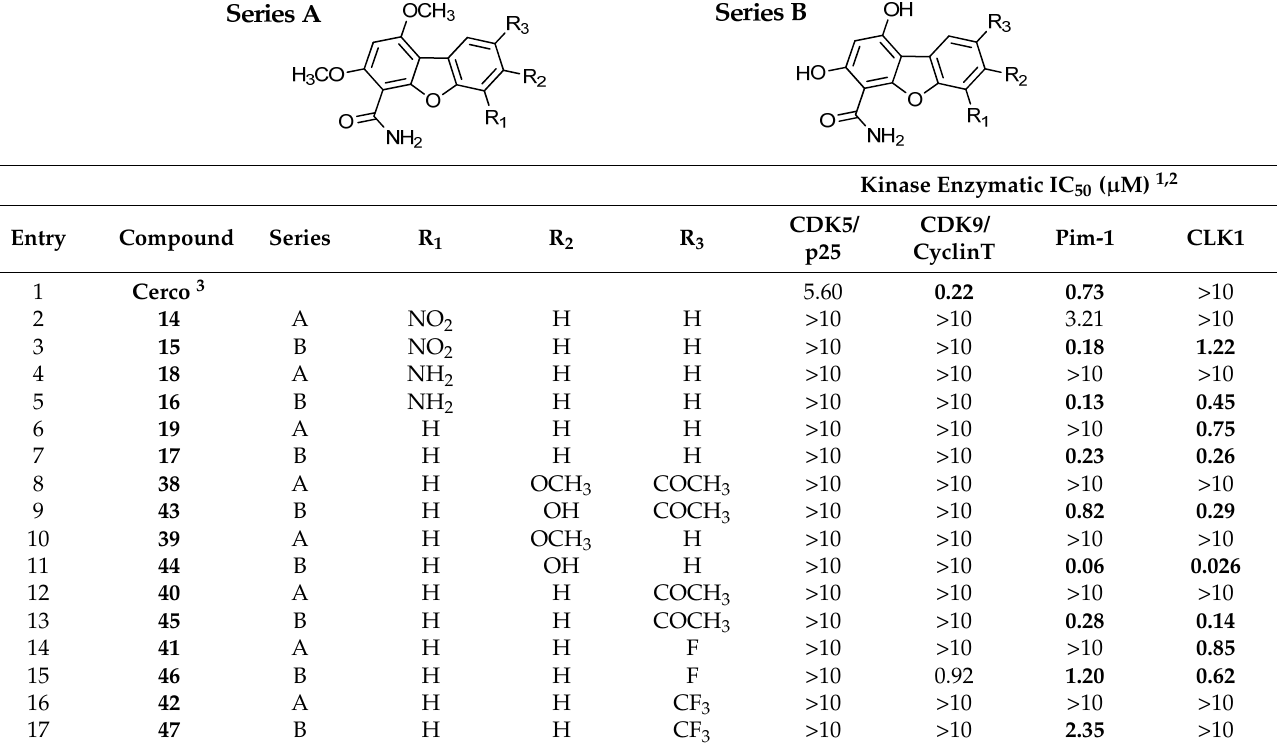
1 IC 50 values were calculated from dose–response curves. Each inhibitor concentration was tested in duplicate. All protein kinases